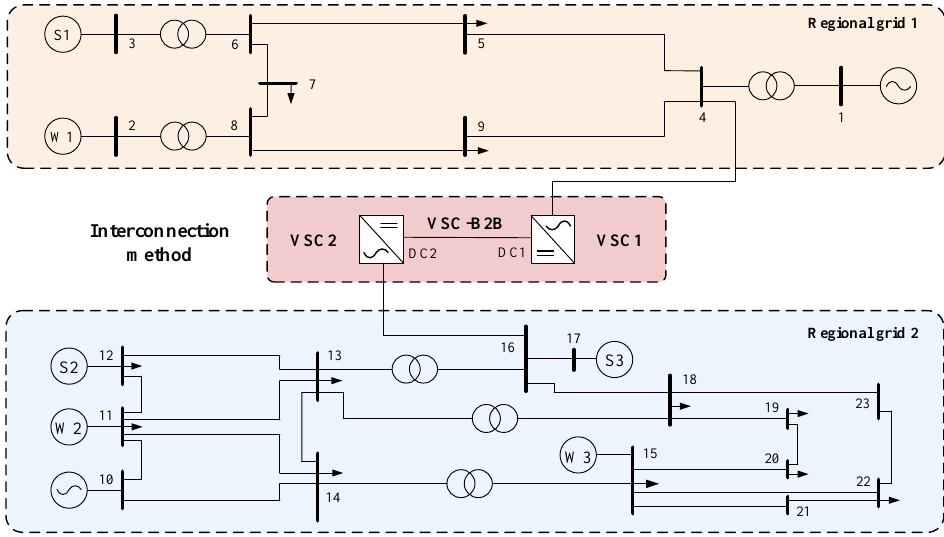
Figure 6. The topology of the interconnected grid based on the B2B-VSC.